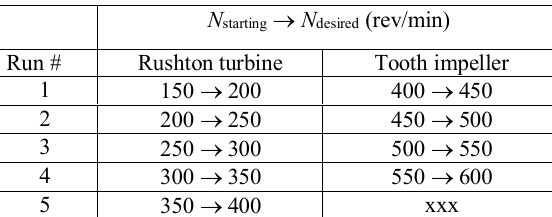
Table 3. Experimental conditions